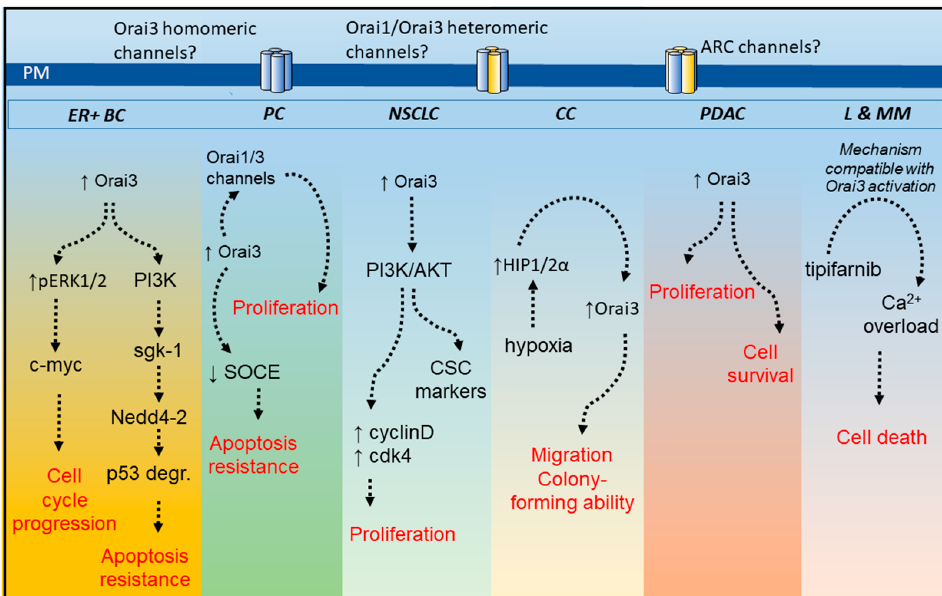
Figure 2. Overview of Orai3 functional role in cancer cells. Orai3 expression has been reported to be up-regulated in different cancer cell types, including those from estrogen receptor-positive breast cancer (ER + BC), prostate cancer (PC), non-small cell lung cancer (NSCLC) cells, colorectal cancer (CC), pancreatic ductal adenocarcinoma (PDAC) as well as tipifarnib-sensitive acute myeloid leukemia and multiple myeloma (L and MM). Except in leukemia and multiple myeloma cells, Orai3 plays a relevant role in the development or maintenance of different cancer hallmarks, such as cell cycle progression and proliferation, apoptosis resistance and survival and migration and colony formation. In tipifarnib-sensitive leukemia and multiple myeloma cells Orai3-mediated Ca 2+ influx is activated by tipifarnib leading to Ca 2+ overload and loss of cell viability. PI3K, phosphatidylinositol 3-kinase; ARC channels, arachidonic acid-regulated calcium channels; ERK, extracellular signal-regulated kinase; sgk-1, serine/threonine-protein kinase-1; p53 degr., p53 degradation; cdk-4, cyclin-dependent kinase-4; CSC, cancer stem cells; HIP1/2 α , hypoxia inducible factor 1/2 α ; ↑ means overexpression or activation and ↓ means inhibition.